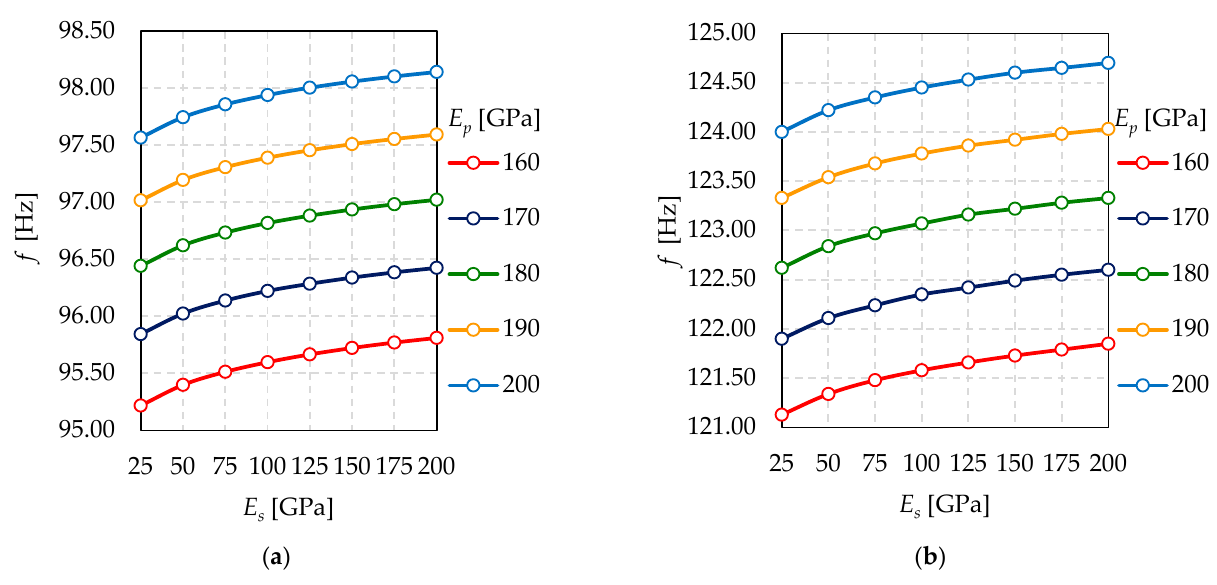
Figure 17. The relationship between natural frequency ( f ) and sealing Young’s modulus ( E s ) for different pillar Young’s modulus ( E p )—( a ) mode shape n = 1; ( b ) mode shape n = 2 .